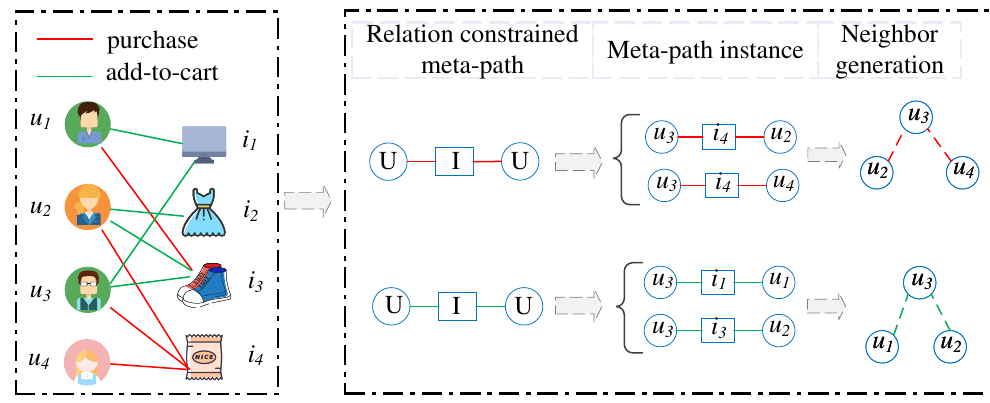
Figure 2. A relation-constrained metapath instance and neighbor generation. In the heterogeneous graph, all the instances are generated according to the relation-constrained metapaths. After filtering metapath instances according to the type of first node in sequence, the neighbors in the same scene can be obtained. Finally, we obtain subgraphs with the same node type, such as, user–user or item–item subgraphs, which can capture high-order proximity between nodes under the specific user